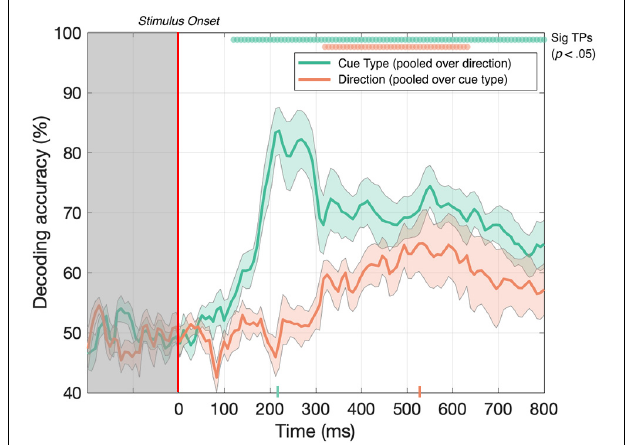
FIGURE 4 | Decoding accuracy across 125 time points for cue type (pooled over motion direction) in green and 3D-motion direction (pooled over cue type) in red. The colored ticks on the x -axis represent the time point of peak accuracy for each condition. Green and red circles indicate the points of time when the Bonferroni-corrected t -tests were significant ( p < 0.05). Shaded error bars represent ± 1SE of the bootstrapped mean (1000